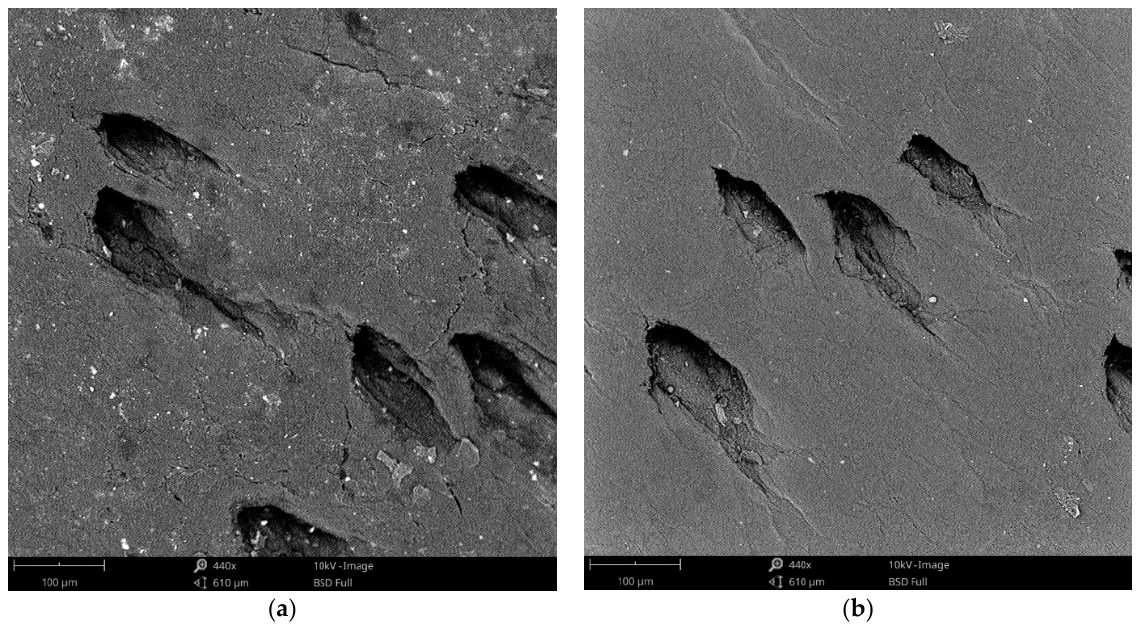
Figure 5. SEM images obtained before and after plasma polimerisation (440×). ( a ) Untreated leather; ( b ) Plasma coated leather.